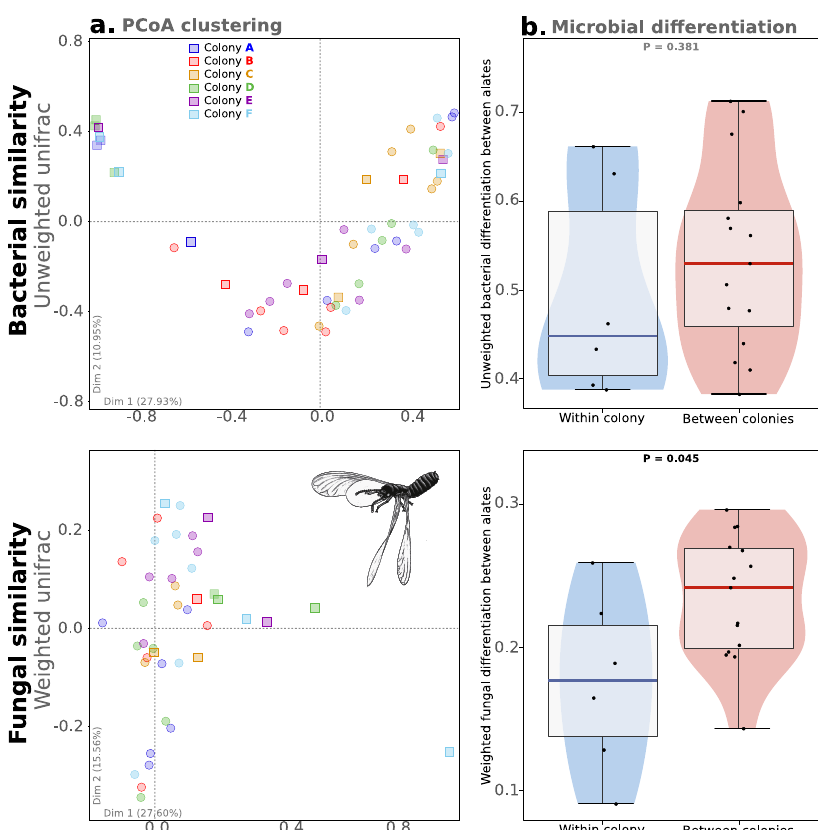
Fig. 4 Microbial similarity within and among colonies. a Principal Coordinate Analyses (PCoA) of individuals based on their unweighted Unifrac values for bacterial similarity and weighted Unifrac values for fungal similarity. Each individual is colored according to its colony of origin, alates are indicated with circles and workers with squares. b Violin plots of bacterial (unweighted Unifrac) and fungal differentiation (weighted Unifrac) among individuals within and between colonies. Box plots represent median and 1st and 3rd quartile; whiskers include 95% of all observations; dots indicate individual values. Results for weighted Unifrac bacterial similarity and unweighted Unifrac fungal similarity are provided in Supplementary Fig.